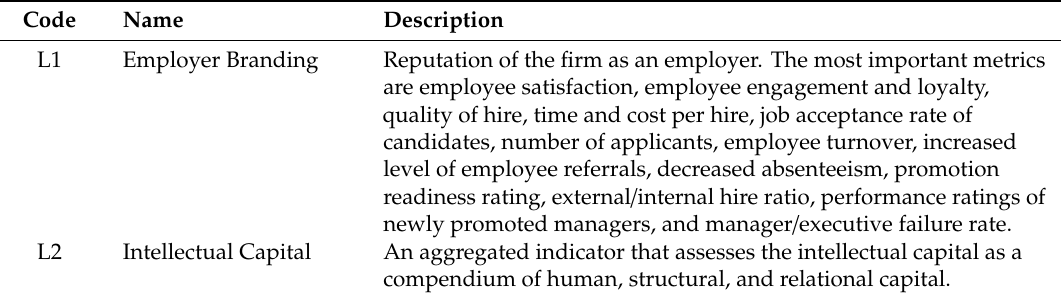
Table 4. Summary of the learning and growth perspective key performance